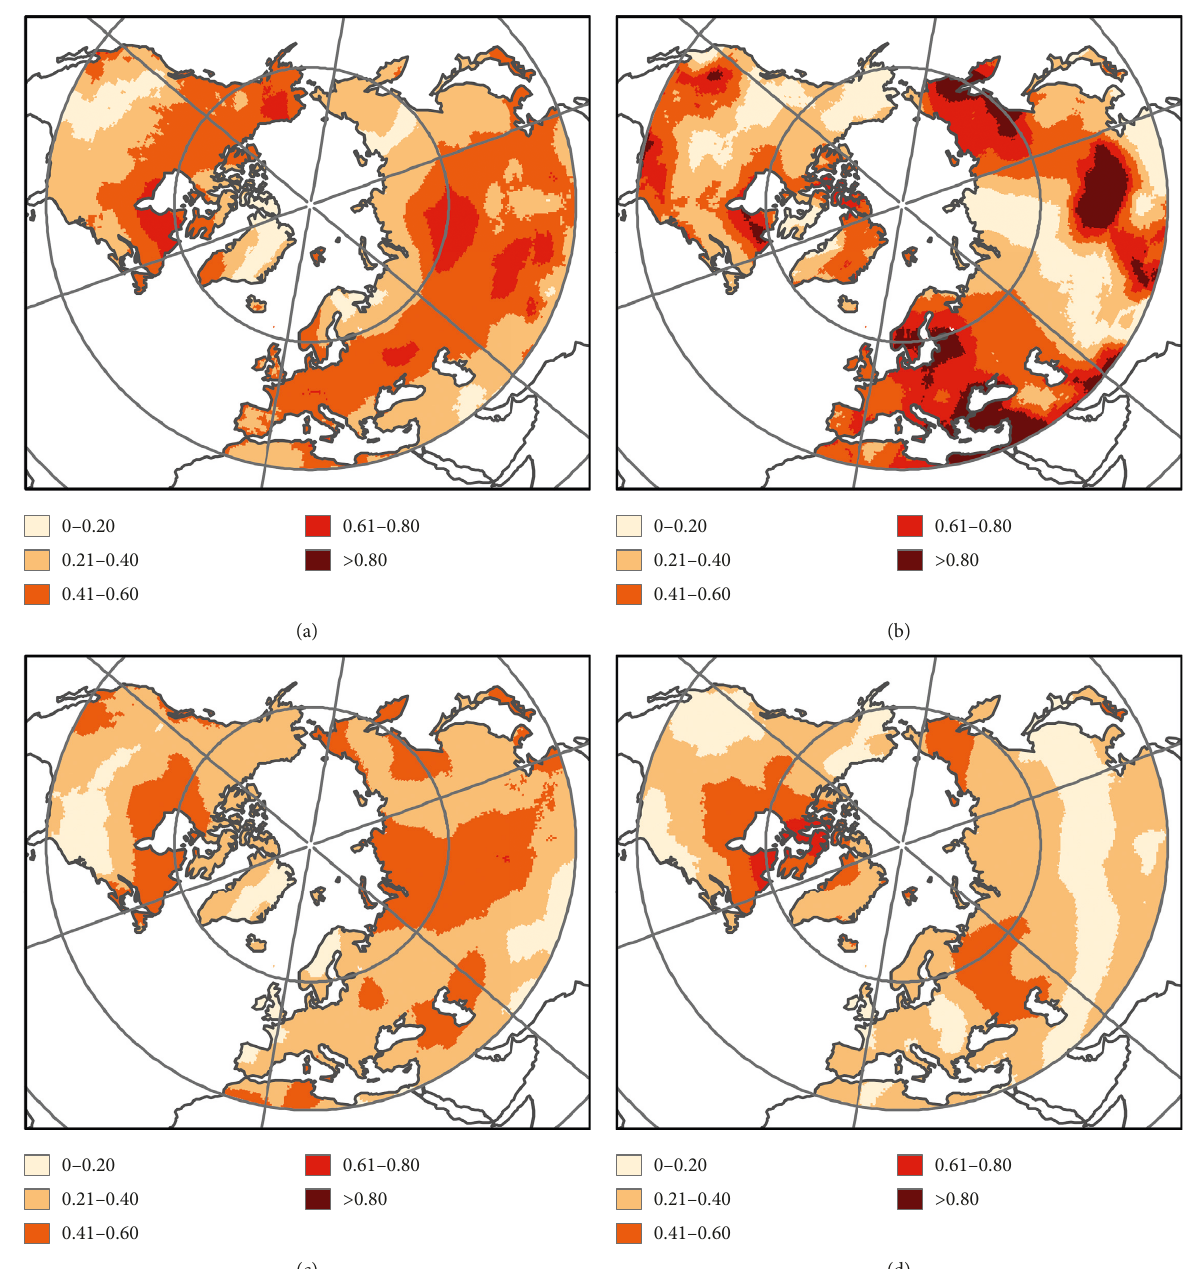
Figure 7: The spatial distribution of the sum of eight determination coefficients describing the relationship between (a) T , and (d) T and selected Northern Hemisphere teleconnection (c) T apr oct